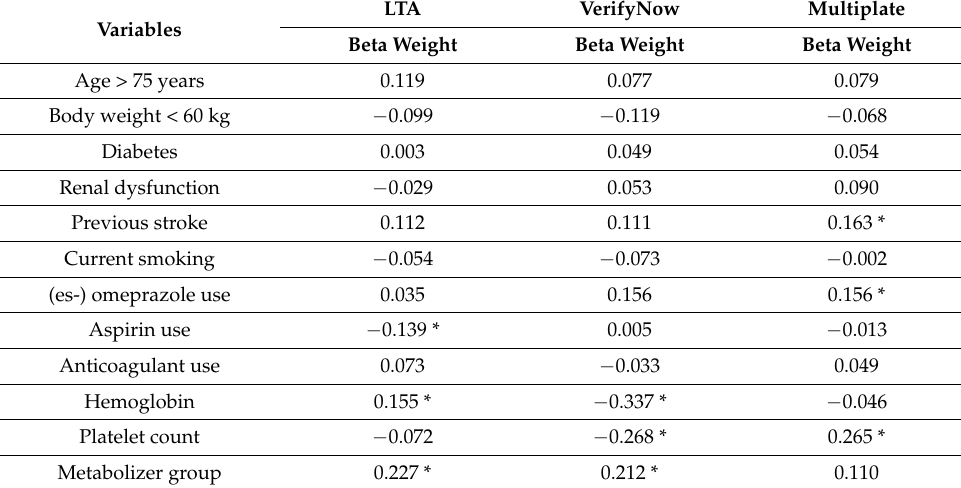
Table 4. Standardized regression coefficients (beta weights) of the multivariable model indicating the relative importance of the different variables on platelet reactivity as measured by the platelet function